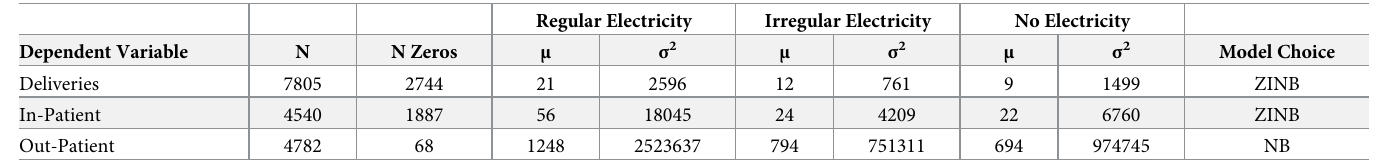
Table 1. Conditional means and variances for outcome variables, and model